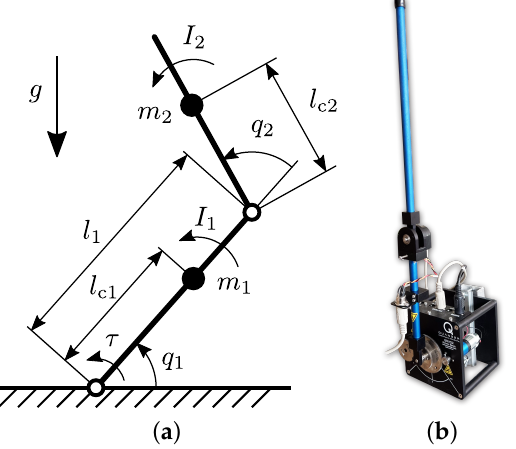
Figure 1. Scheme of the Pendubot: ( a ) basic model: m i —mass of i th link, I i —moment of inertia of i th link determined with respect to the axis normal to the plane and moving through the center of mass of the link, l i —length of i th link, l c i —distance between the revolute joint and the center of mass of i th link, g —gravity acceleration, ( b ) the real system used in experimental